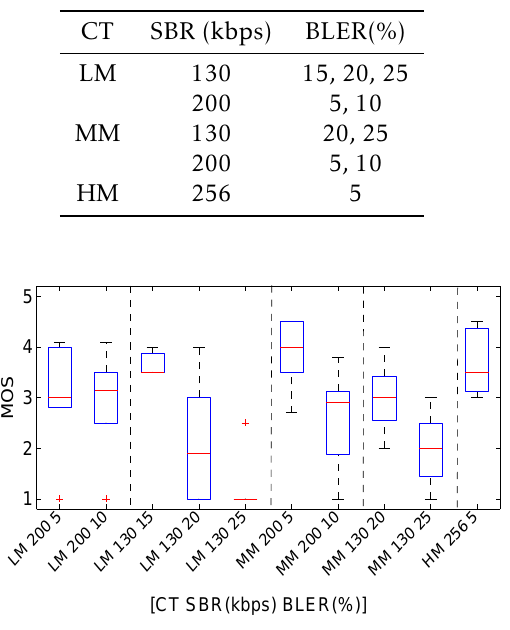
Figure 3. Boxplot of subjective testing results for UMTS transmission of QVGA sequences.